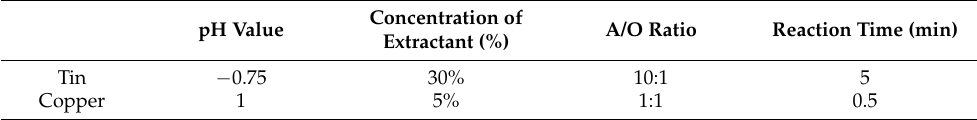
Table 4. Optimal parameters of extraction